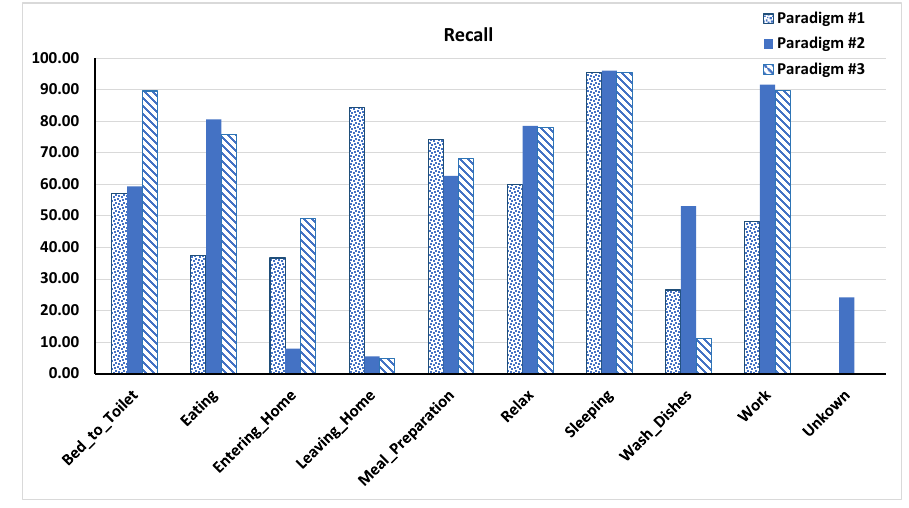
Figure 6. Recall values of the proposed three paradigms.